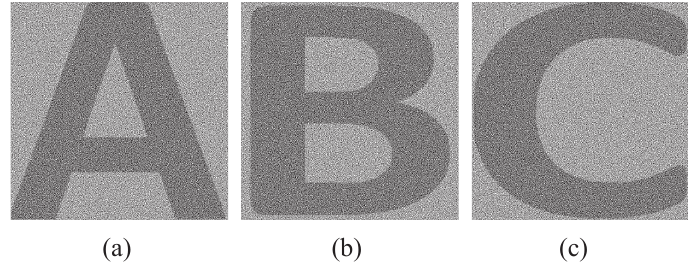
Figure 11. Binary meaningful shadows of the proposed ( 3,3 ) -SDIS: ( a ) BS 1 ( b ) BS 2 ( c ) BS 3 . Experiment C . Three color meaningful shadows CS 1 − CS 3 of the proposed ( 3, 3 ) -SDIS sharing a 256-color secret image are